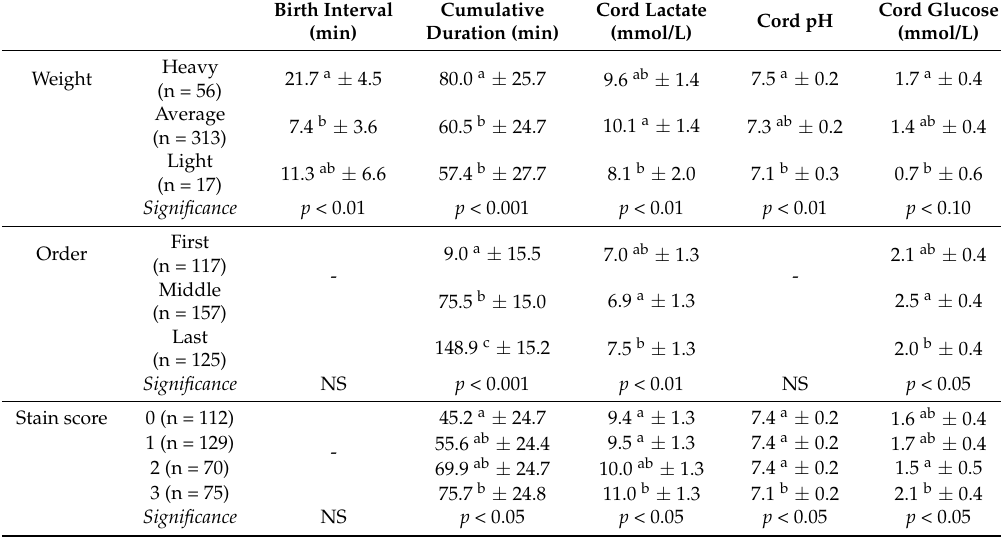
Table 3. Mean ± s.e.m inter-piglet birth interval, cumulative birth duration, and cord blood measurement of lactate, pH, and glucose for piglets classed as heavy (>1.8 kg), average (0.8 kg to 1.8 kg), or light (<0.8 kg), first (1 to 4), middle (5 to 8), or last (>9) in the birth order, and those with no meconium staining (score 0) to those heavily stained (score